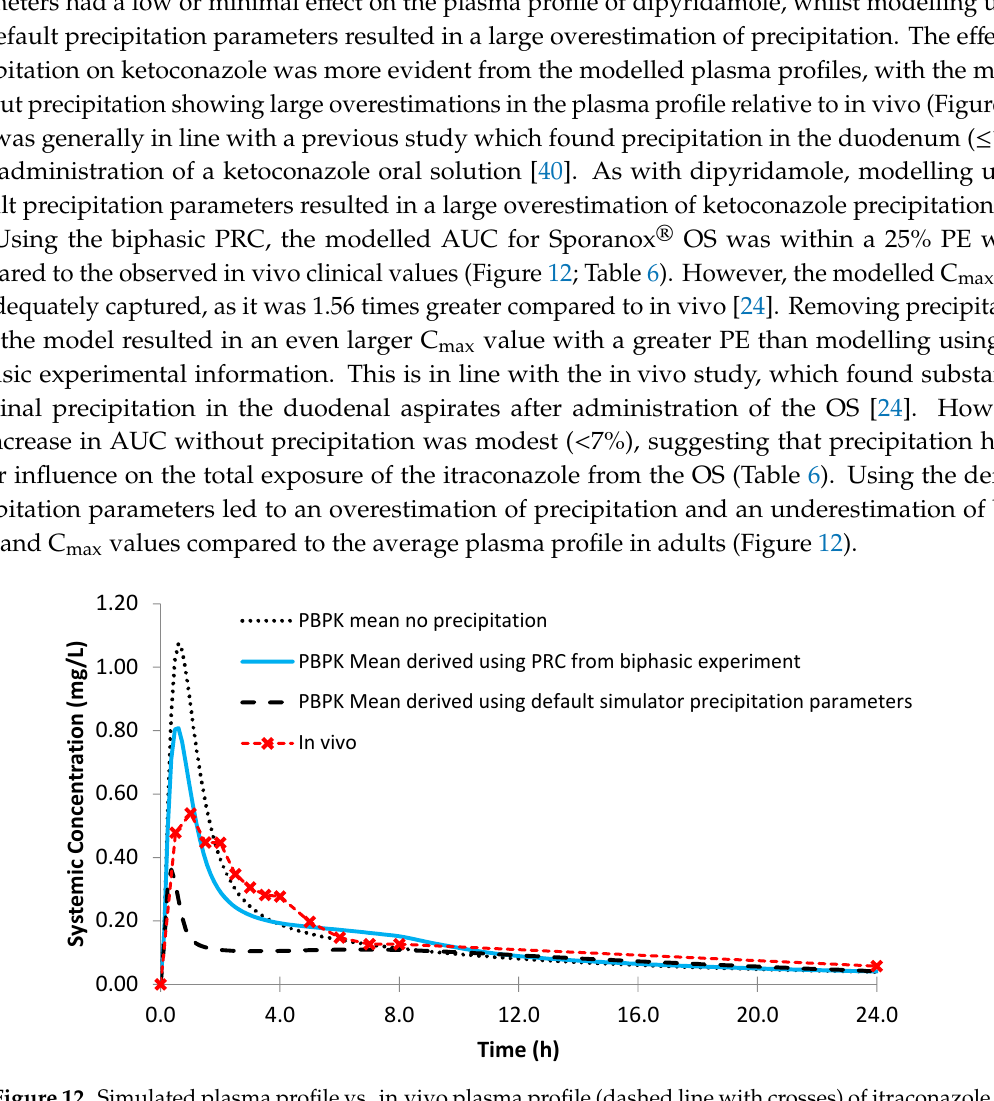
Table 6. Observed and modelled drug exposure pharmacokinetic parameters for 200 mg dose of Sporanox oral solution.